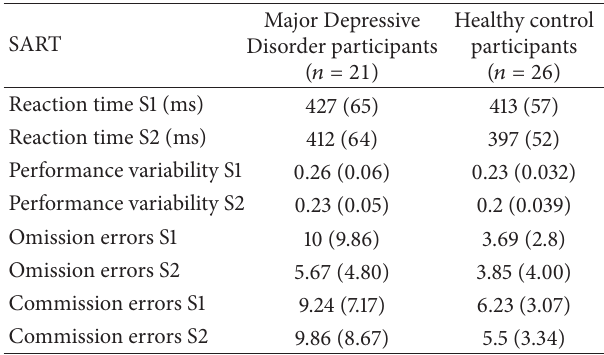
Table 2: Mean and standard deviation of short-term cognitive data of participants.